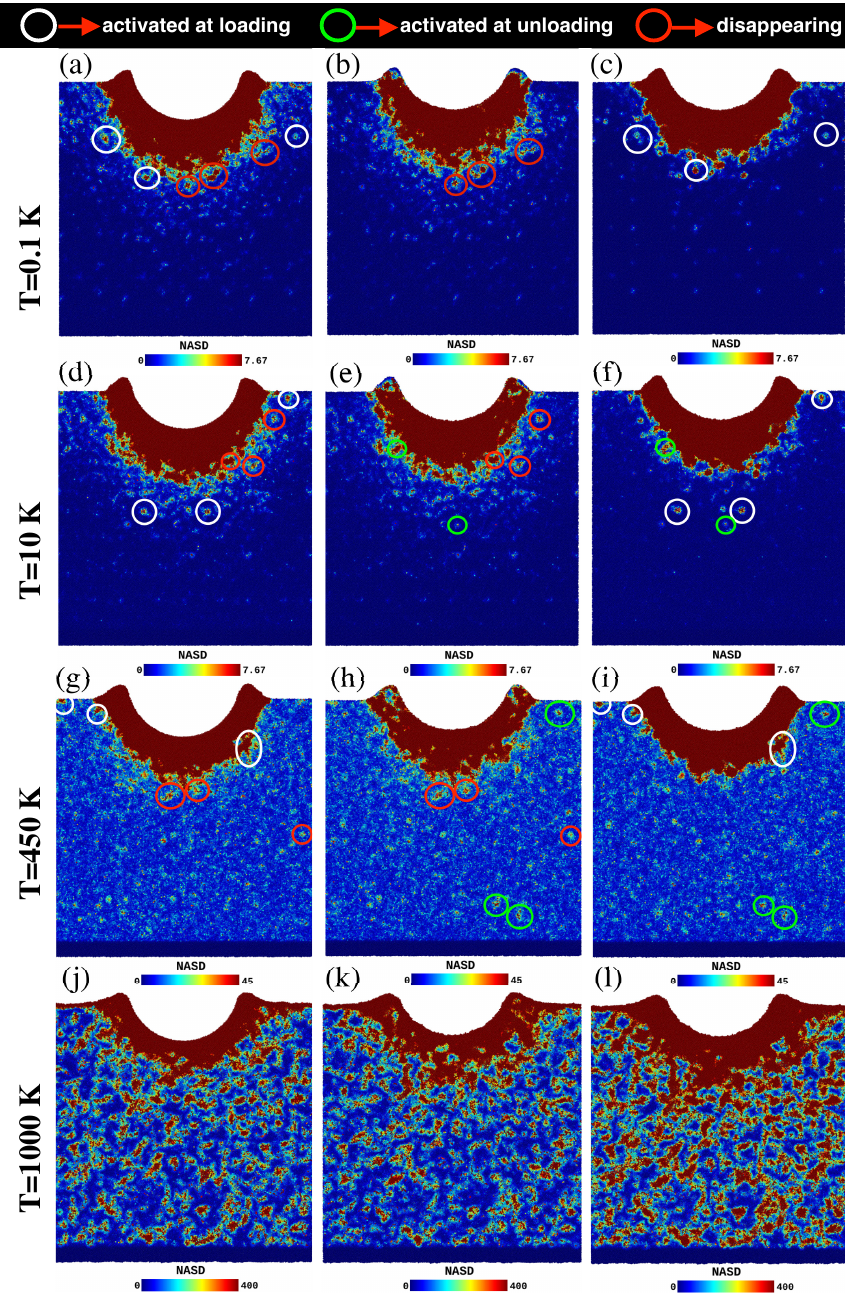
Figure 6. Non-affine squared displacement (NASD)—in units of Å 2 —at indentation rate of 20 m/s and temperatures of ( a – c ) T = 0.1 K, ( d – f ) T = 10 K, ( g – i ) T = 450 K and ( j – l ) T = 1000 K. Left column: ( a , d , g , j ) calculated from the atomic configuration at the maximum indentation depth with reference to the atomic configuration before indentation. Middle column: ( b , e , h , k ) calculated from the atomic configuration after unloading with respect to the atomic configuration at the maximum indentation depth. Right column: ( c , f , i , l ) calculated from the atomic configuration after unloading with respect to the atomic configuration before loading. The white circles highlight plastic regions that appear during loading and stay through the unloading process. The red circles enclose plastic regions that were activated during loading, but disappear during unloading, and the green circles feature plastic regions that appear during